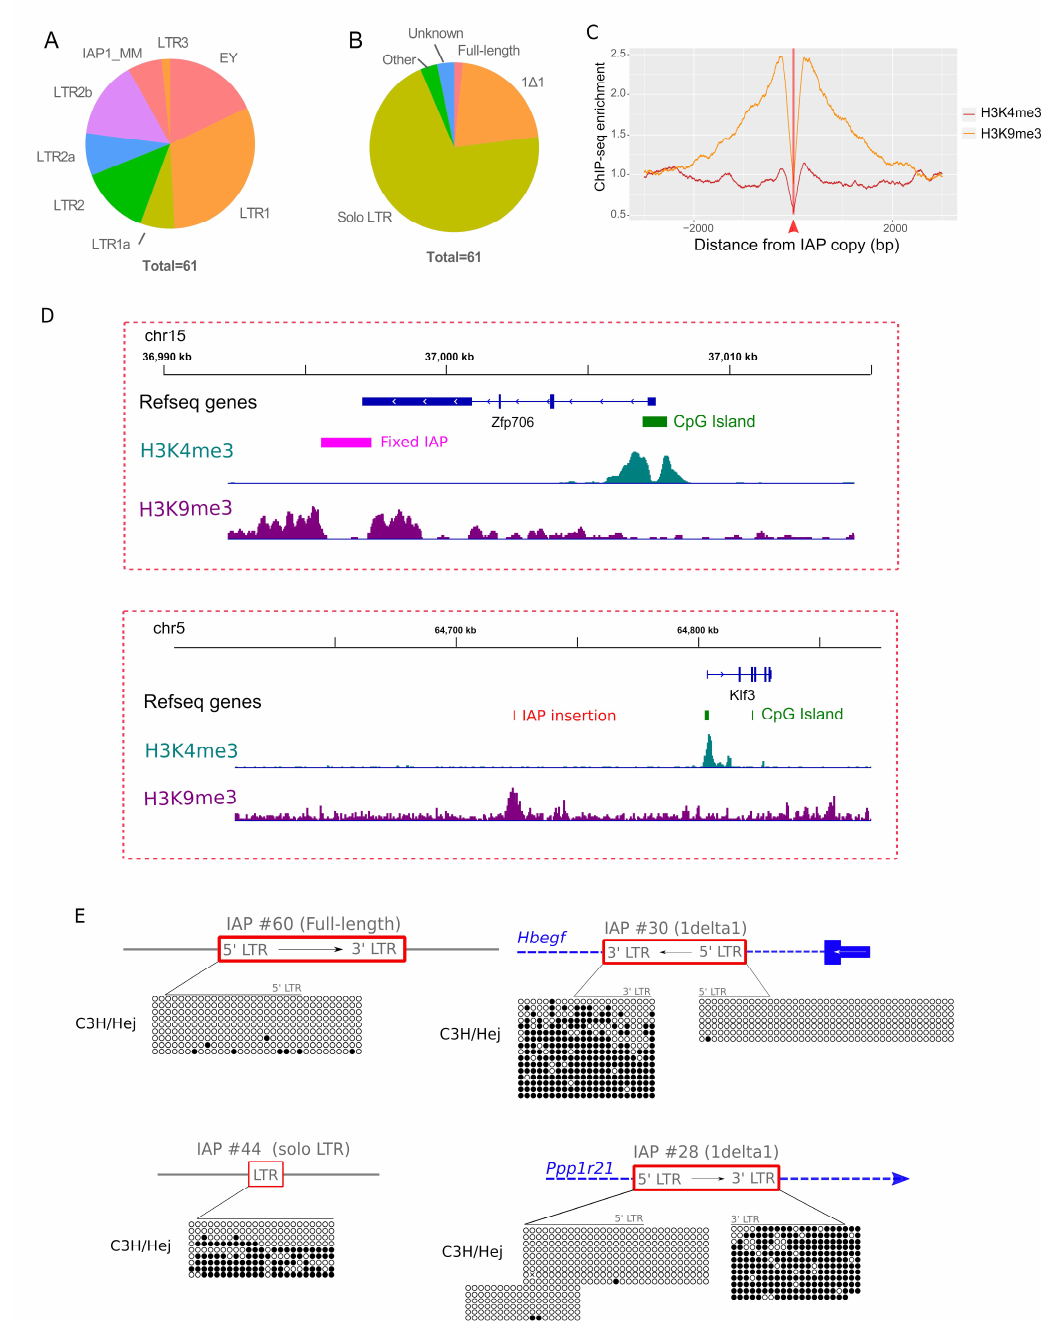
Figure 3. The C3H/HeJ ES cell genome has 61 IAP copies associated with H3K4me3. ( A ) Distribution of IAP subfamilies among the 61 H3K4me3-IAPs. Most IAP subfamilies are young (LTR1, lTR2 and EY). ( B ) Distribution of IAP types among the 61 H3K4me3-IAPs. ( C ) Average H3K4me3 and H3K9me3 in the flanking regions of all IAP insertions in the C3H/HeJ genome. The red arrow and line represents the IAP insertion site. ( D ) IGV genome browser view of IAP copies, either fixed (top panel) or C3H/HeJ specific (bottom panel), enriched in H3K9me3 in C3H/HeJ and lacking H3K4me3. For comparison, the closest H3K4me3-marked promoter is shown. ( E ) Bisulfite analysis of four H3K4me3-IAPs, including the full-length copy. Empty circles are unmethylated CpGs and full circles are methylated ones. An arrow depicts the IAP sense and a line above the CpG circles represents the CpG within the LTRs. In red, IAP insertions; in blue, genes; in black, intergenic regions.